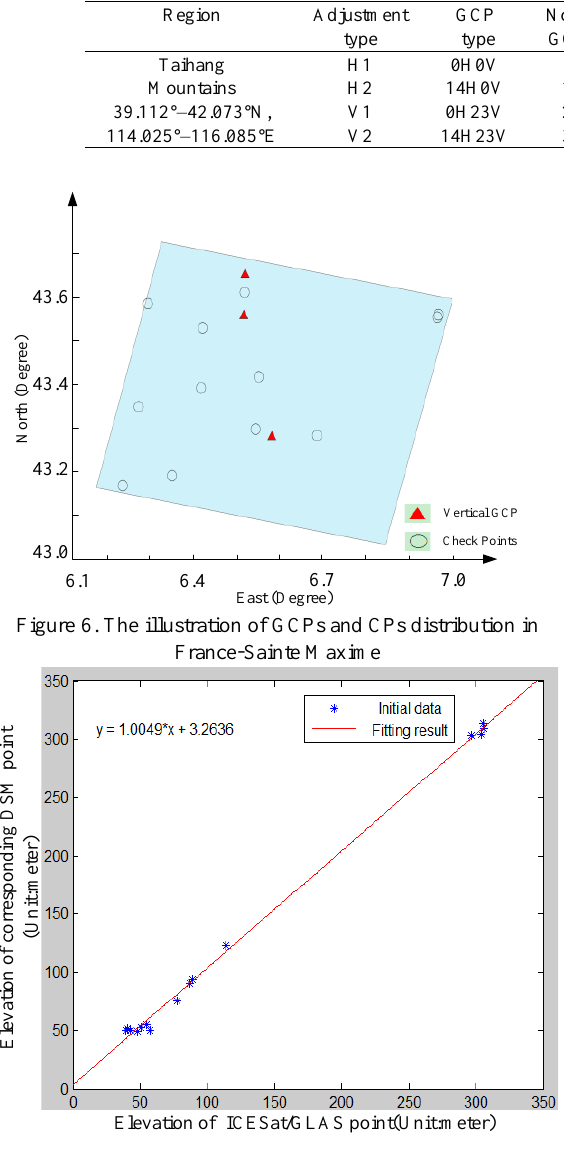
Figure 7. The elevation illustration of ICESat/GLAS points and corresponding DSM points; The red line is the fitting result according to Eq.(10), in which a = 1.0049, b = 3.2636. In the Sainte-Maxime of France experimental region, the initial elevation accuracy is about 5.61m and maximum error is 12.52m, and the RMS of adjustment result using GLAS as elevation control points is 3.12m and maximum error is 6.51m, while the RMS of correcting DSM by GLAS linear fitting only reduced to 5.13m and maximum error is